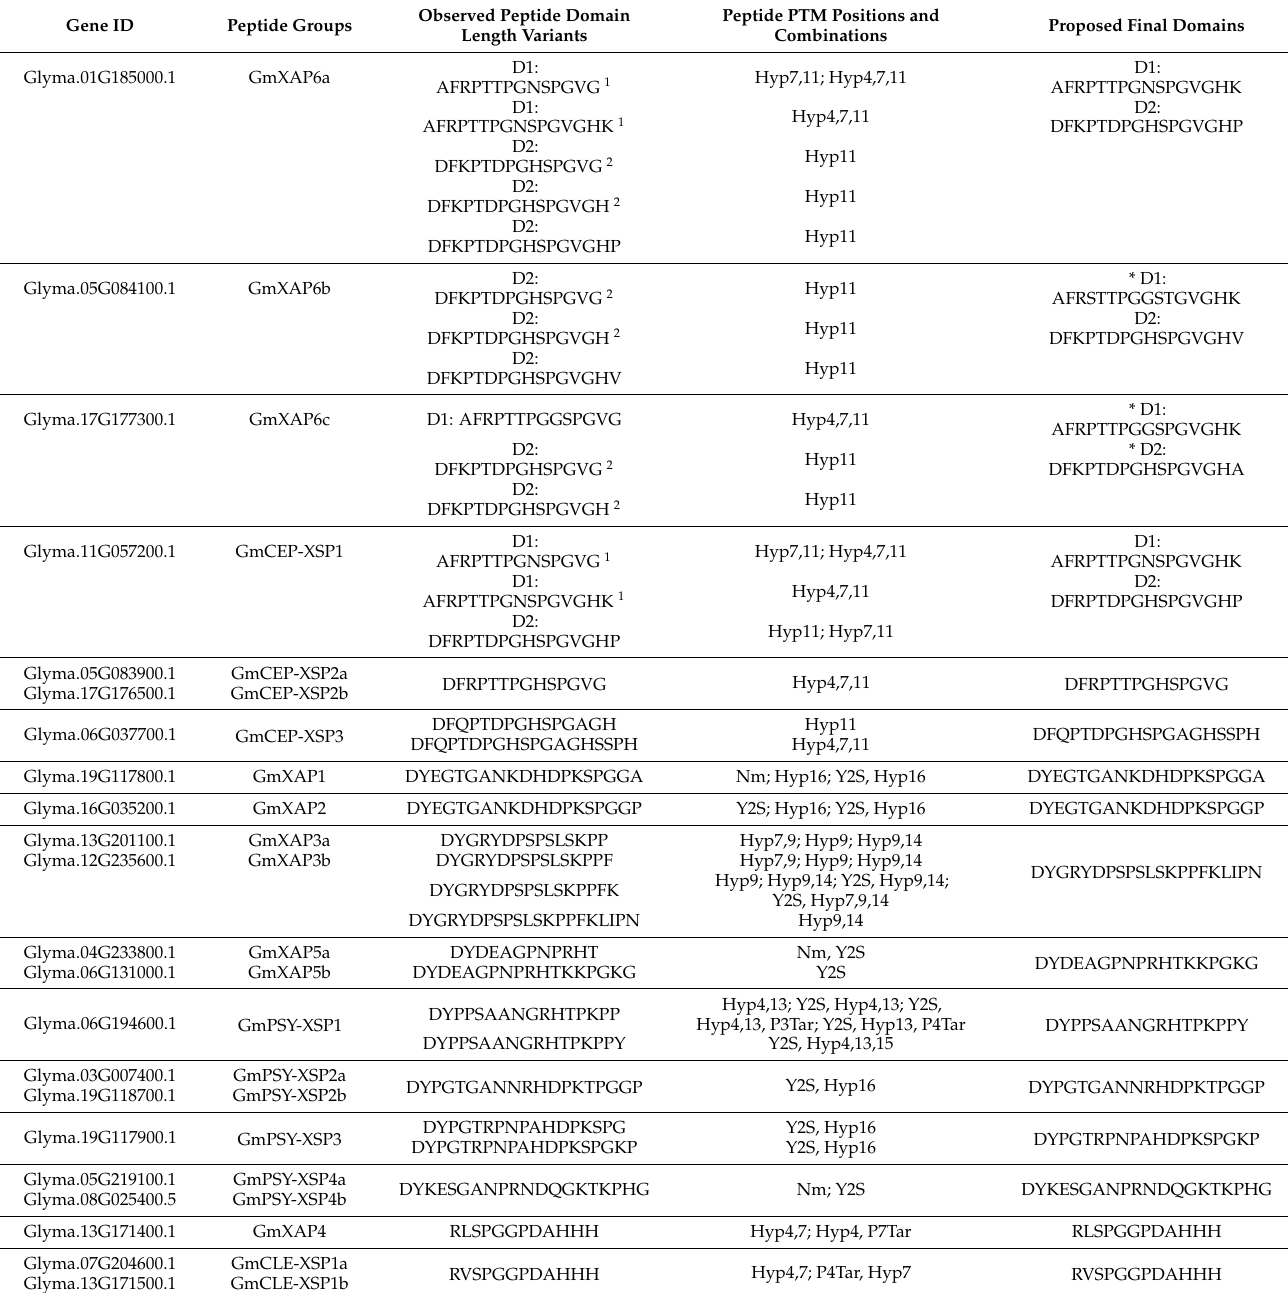
Table 1. Identification of plant-secreted peptide sequences from soybean xylem sap by LC-MS/MS. The peptide sequences are categorized based on peptide family classification into CEP, PSY and